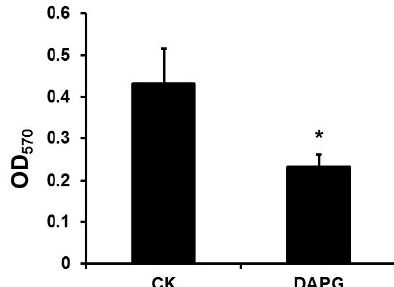
Figure 4. DAPG inhibited the biofilm formation of S. aureus Sta24-1. S. aureus Sta24-1 was incubated